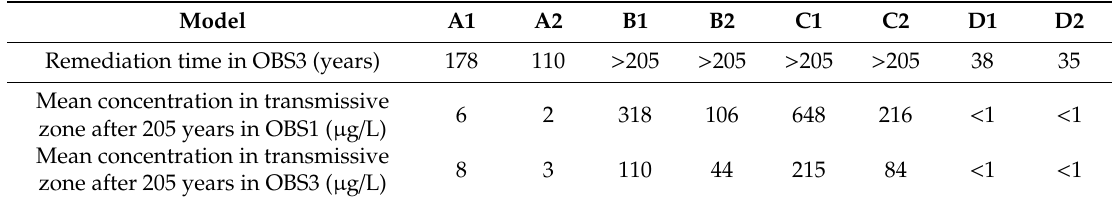
Table 6. Numerical model results.